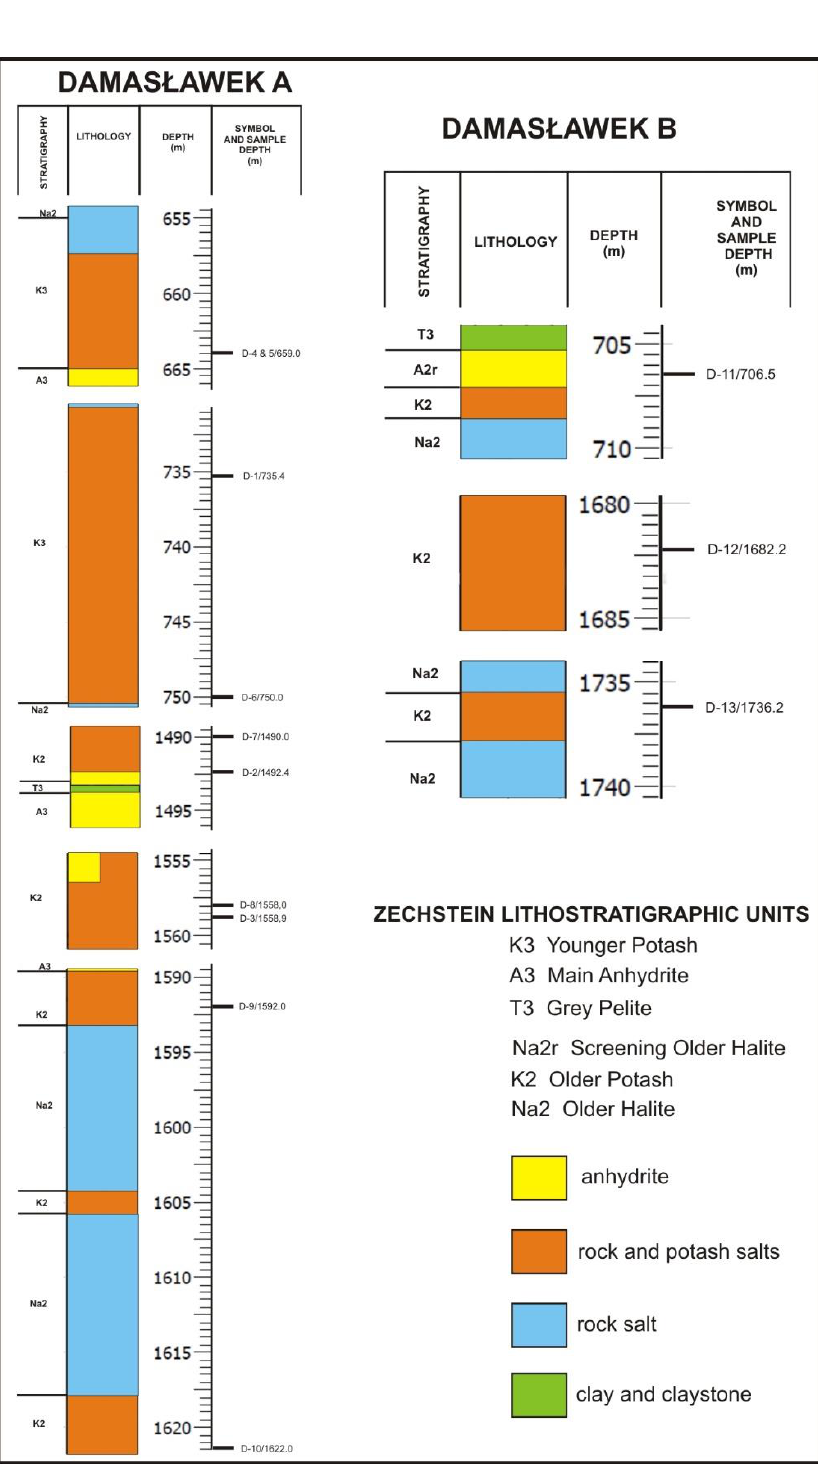
Figure 6. Sampled parts of the Damasławek A and B boreholes profiles with Na2+K2, K2, and K3 lithostratigraphic units, Damasławek salt dome.